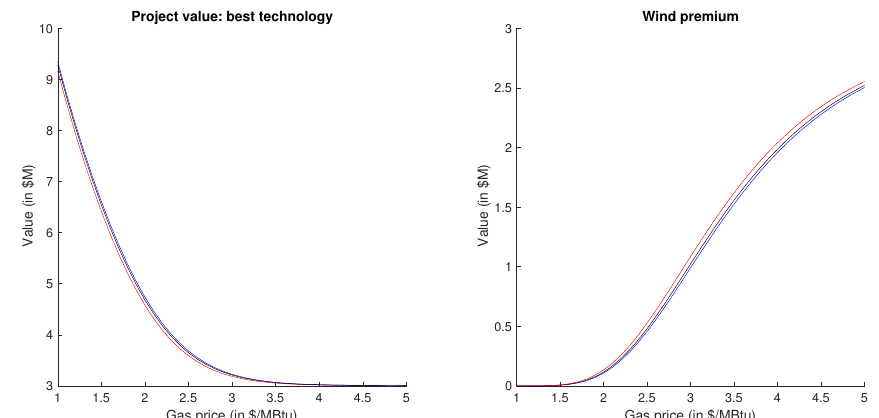
Figure 13. This figure displays the effects of ¯ i 1 on the project value (left panel) and wind premium (right panel) at t = 0 when A = 0, B = 1, C = 2.5. The value of X 0 is 50$/MWh. The values of ¯ i 1 are: ¯ i 1 = 120/327,000 (blue), ¯ i 1 = 5000/327,000 (black), ¯ i 1 = + ∞ (red). Other parameter values are given in Table 1; the investment horizon is T = 1 year.